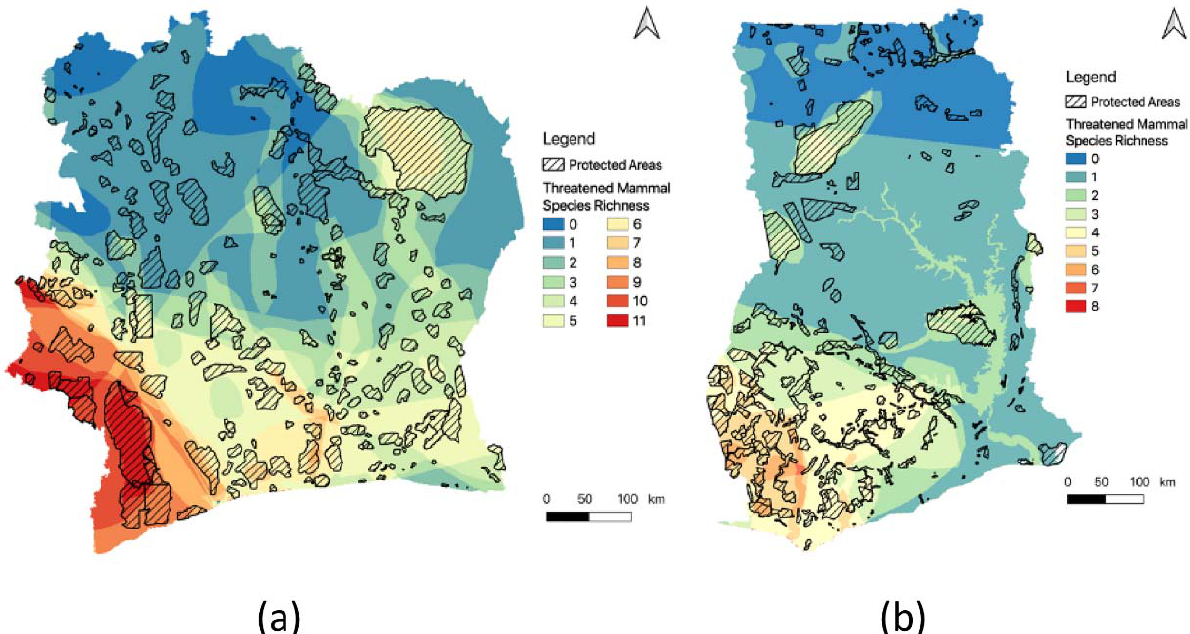
Figure 3. The threatened mammal species richness overlaid with the protected area network of ( a ) Côte d’Ivoire and ( b ) Ghana, West Africa. Table 7. Summary statistics (median, mean, and CI for mean value) for threatened mammal species richness in Ghana and Côte d’Ivoire’s protected areas (IUCN PA categories, those without assigned categorizations (not reported) and World Heritage Sites or UNESCO MAB reserves (not applicable)). C ô te d’Ivoire Ghana Threatened Mammal Species Richness IUCN